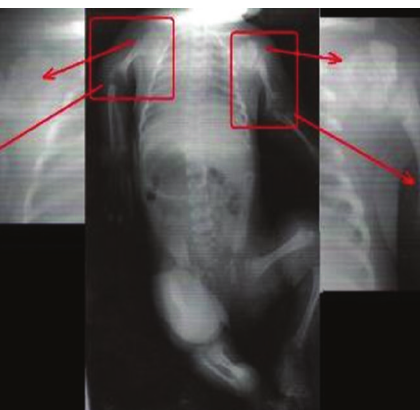
Figure 1: Proximal shortness, thick and short diaphyses, large and irregular metaphyses, and punctate calcifications in the epiphyses in the long bones and coronal clefts not included in the vertebral bodies.